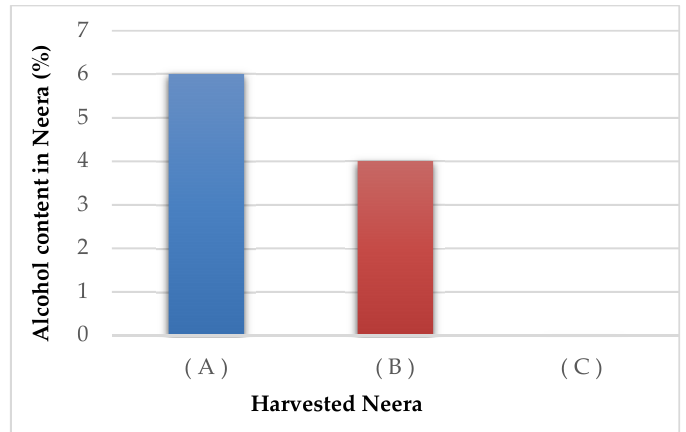
Figure 5. The percentage of alcohol content in coconut Neera. ( A ) Neera harvested traditionally; ( B ) Neera collected in chiller device after tapping; and ( C ) Neera with AFS.